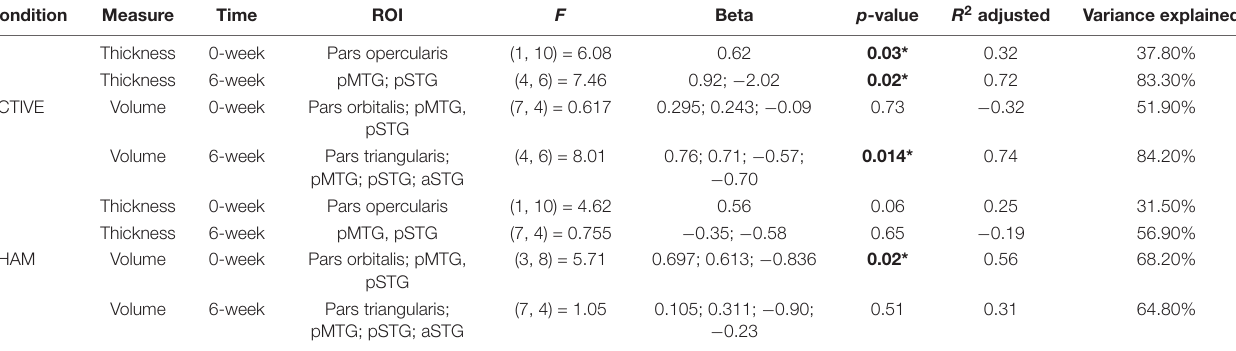
TABLE 3 | Summary of linear regression (backward-fitted model) results for significant thickness and volume ROIs at the 0-week and 6-week time points.